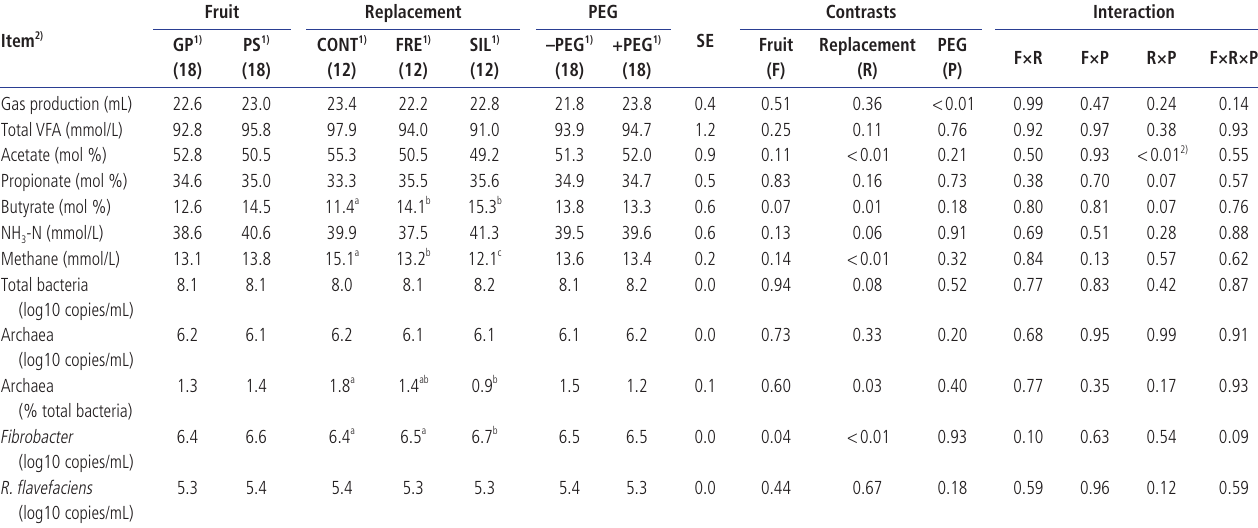
Table 4. In vitro rumen fermentation characteristics of test feeds containing ensiled fruits byproducts and PEG 1)